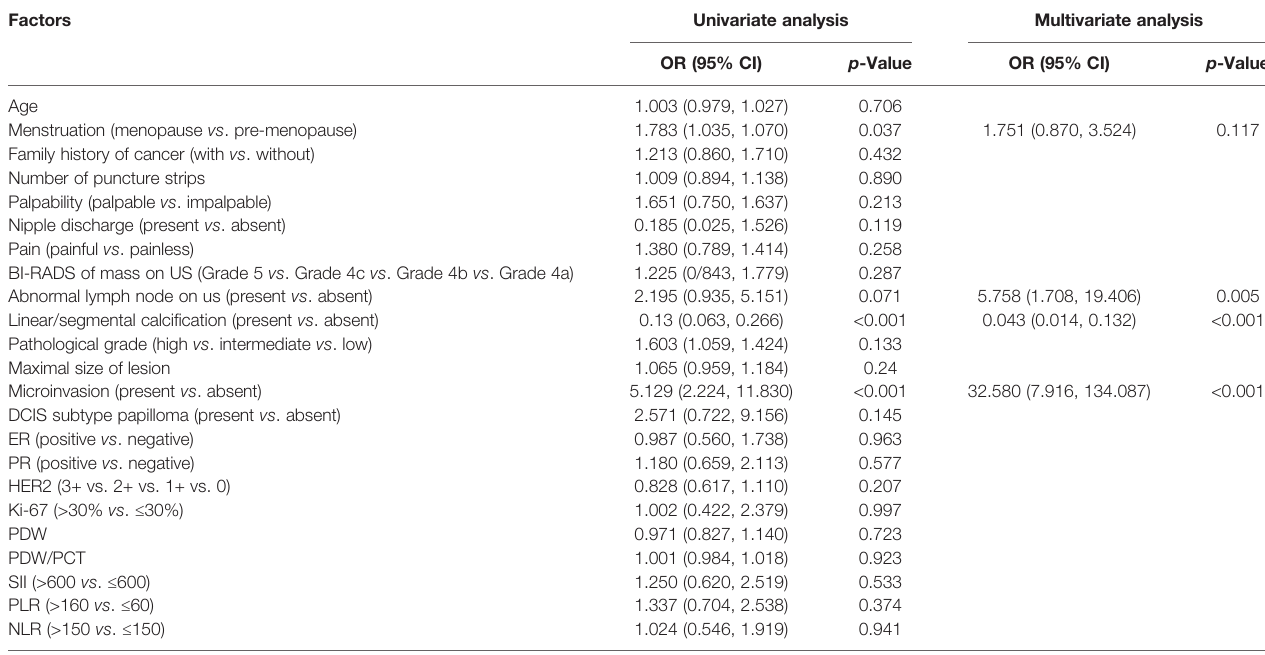
TABLE 2 | Risk predictors for